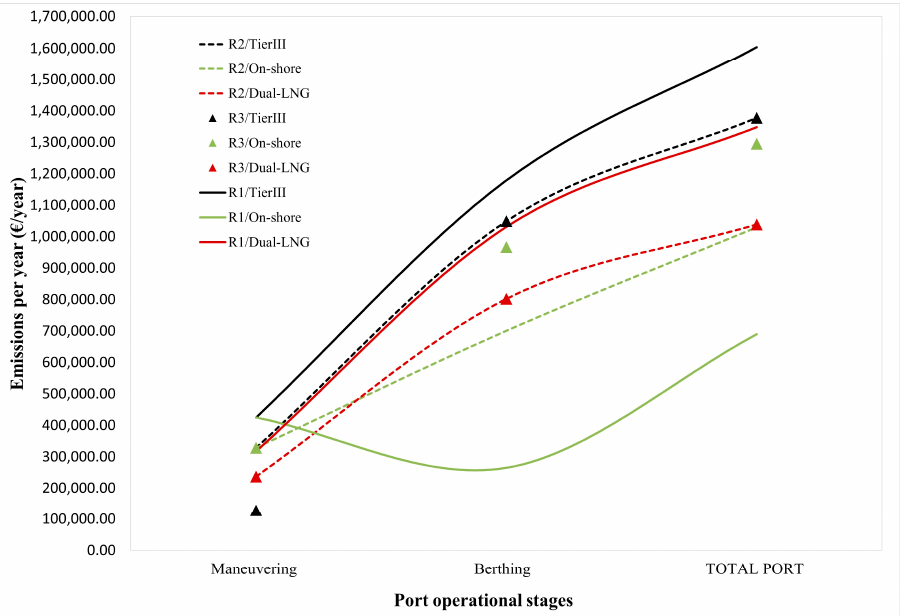
Figure 3. Emissions per year of Ro-Pax vessels in port. R1: Vigo (Spain)–St. Nazaire (France) R2: Las Palmas (Gran Canaria island)–Huelva (Spain) R3: Las Palmas (Gran Canaria island)–Sta. Cruz de Tenerife (Tenerife